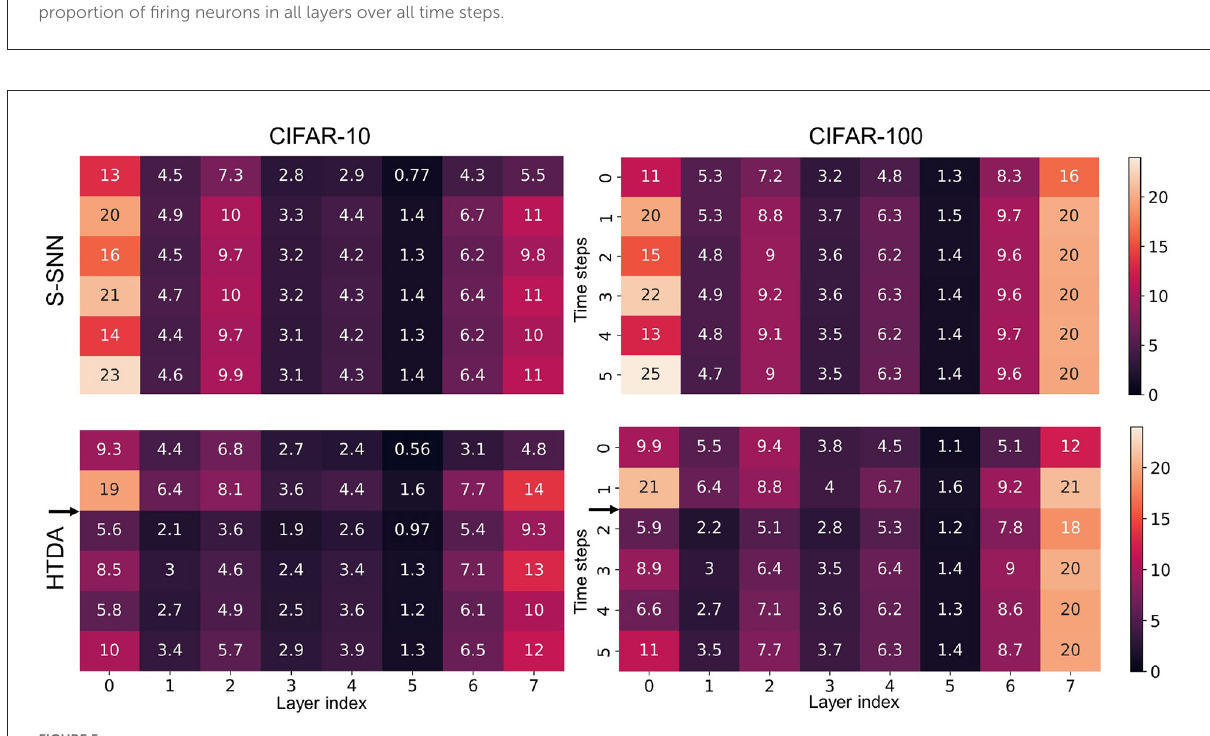
FIGURE5 Firing rates of each layer of the feature extractor (VGG-128c) at different time steps under different settings. The firing rate presented in each cell of the matrix is the proportion of the firing neurons in a certain layer at a certain time step. On both CIFAR-10 and CIFAR-100, the firing rates of the HTDA model after attention decrease